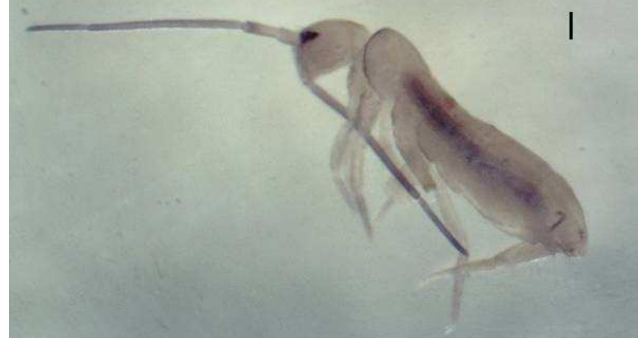
F IGURE 11. T. vulgaris with ling antenna (scale: 1000 µm)